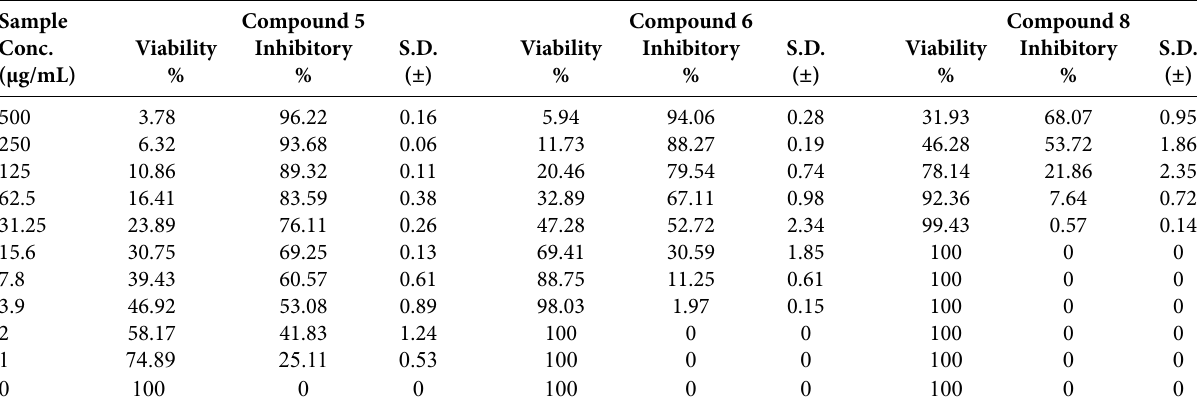
Table 1. Cytotoxic activity against the MCF-7 of tested compounds